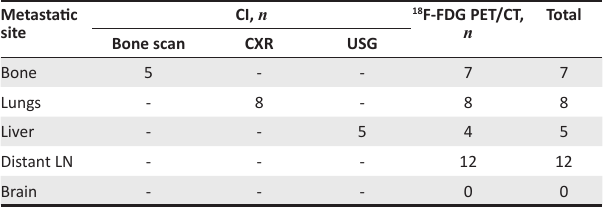
TABLE 3: Metastatic sites † on conventional imaging and 18 F-Fluorodeoxyglucose positron emission tomography/computed tomography.